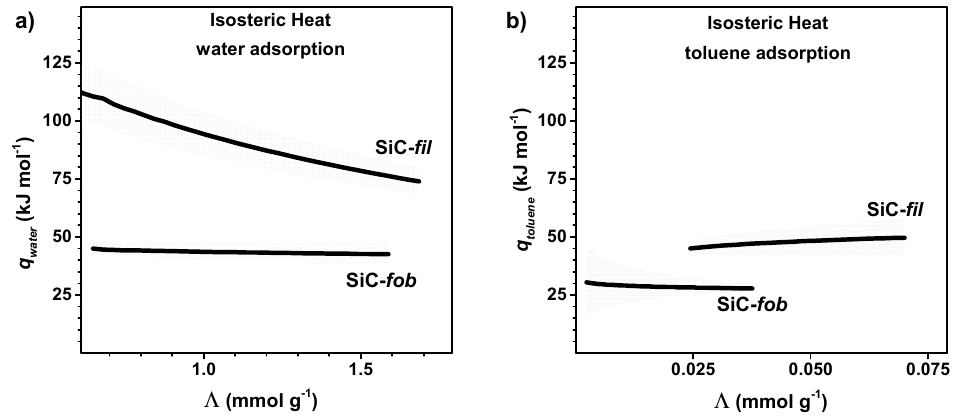
Figure 6. Variation of isosteric heat of adsorption ( q ) with surface coverage ( Λ ) for the adsorption of ( a ) water and ( b ) toluene on SiC- fil and SiC- fob ; q values were calculated by fitting Equation (2) on data in Figure 2, Grays bands indicate error from the fitting.